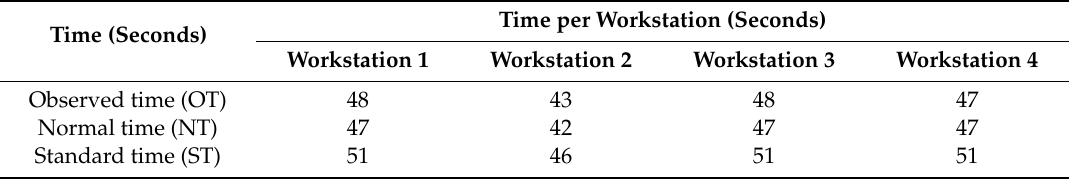
Table 7. Time estimations for the redesigned process.